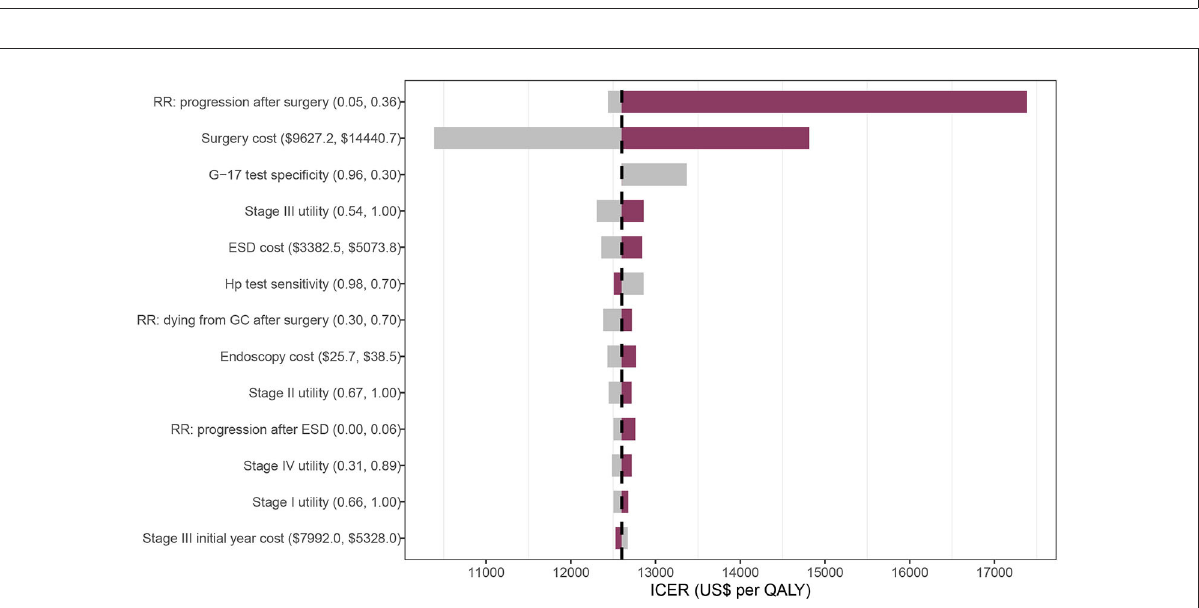
stages I, III, and IV in subgroups (Supplementary Figure S7). In addition, screening in current smokers was more cost- effective than in the overall population or other subgroups (Supplementary Table